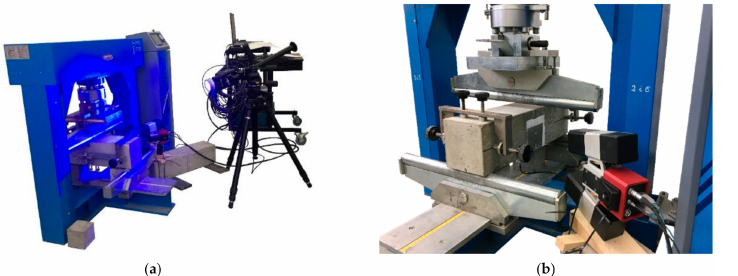
Figure 8. Set-up for monitoring the samples using the DIC system: ( a ) computer for storage the data with the lamp to lightened the studied surface; ( b ) camera.